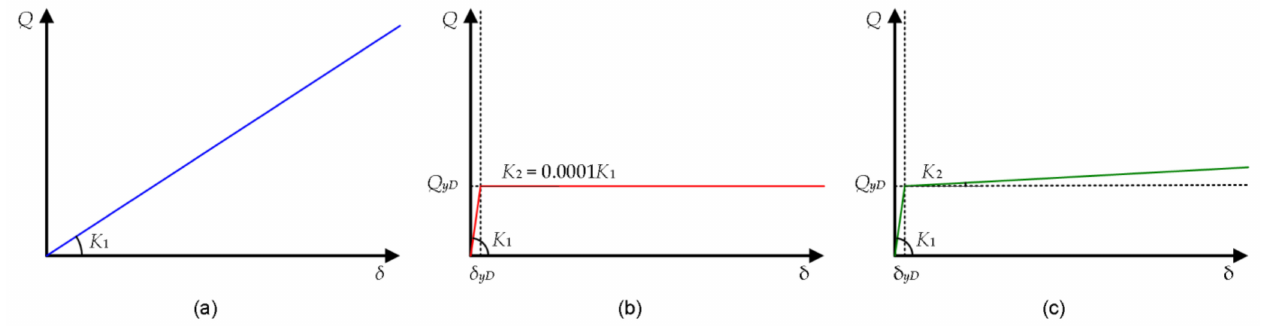
Figure 9. Envelope of the force–deformation relationship for the isolators and dampers: ( a ) Natural rubber bearings (NRBs); ( b ) elastic sliding bearings (ESBs); ( c ) steel dampers.